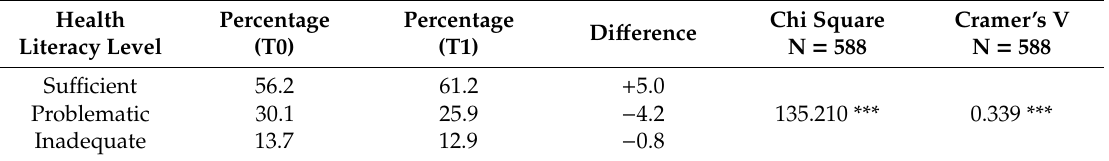
Table 8. Proportion of parents with di ff erent levels of health literacy.